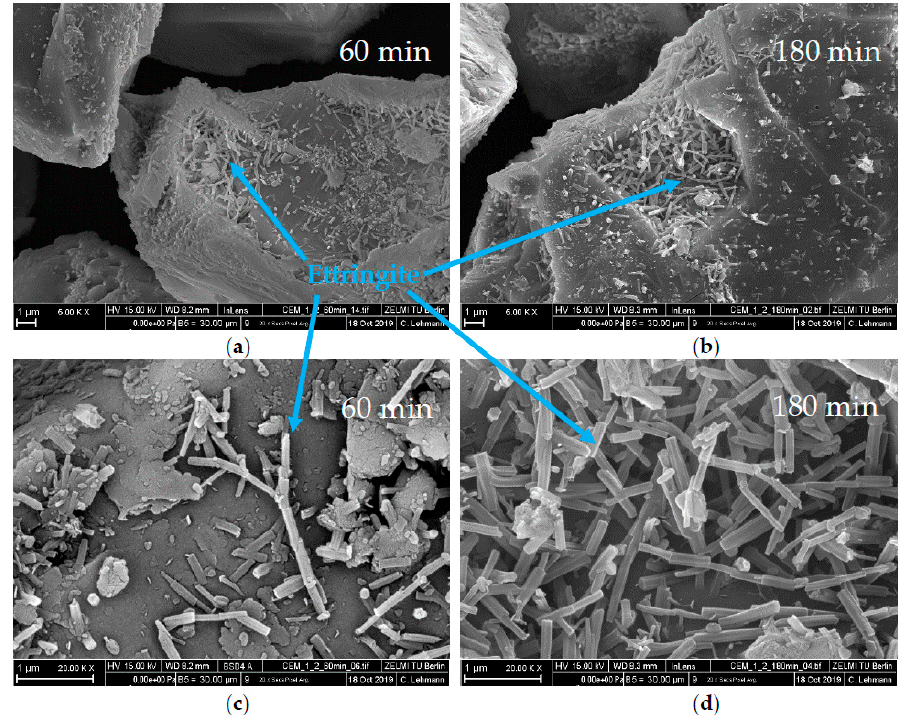
Figure 13. SEM images of CEM I with 0.7 wt% of SP (direct addition), 2 wt% of gypsum, and a w/c ratio of 0.36 after a time of ( a , c ) 60 min and ( b , d ) 180 min. ratio of 0.36 after a time of ( a , c ) 60 min and ( b , d ) 180